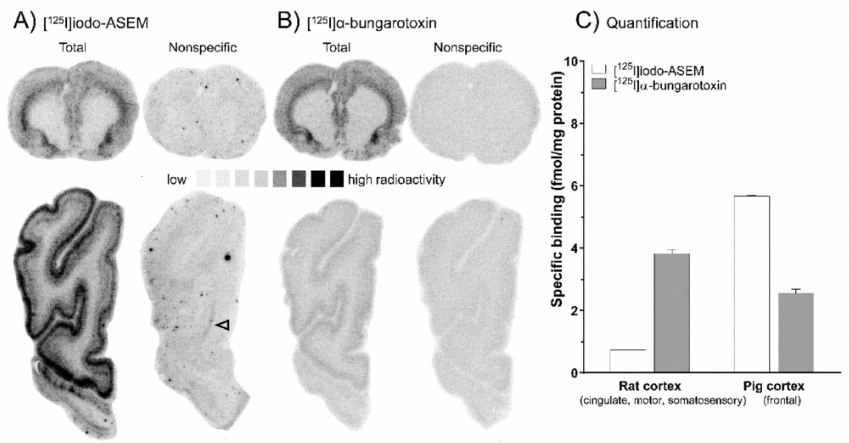
Figure 1. ( A , B ) Representative autoradiographs showing [ 125 I]Iodo-ASEM and [ 125 I] α -bungarotoxin total and non-specific binding (determined with 1 mMol / L (-)-nicotine for [ 125 I] α -bungarotoxin and 10 µ Mol / L SSR-180,711 for [ 125 I]Iodo-ASEM) in 12 µ m sections of the rat (upper row) and pig brain (lower row). Arrowheads indicate residual white matter binding. ( C ) Comparative quantitative analysis of specific binding ( ± S.E.M.) of [ 125 I]Iodo-ASEM and [ 125 I] α -bungarotoxin from autoradiography in the rat (n = 1) and pig cortex ( n = 2). All autoradiographic experiments and quantifications are carried out in 3-4 sections per animal.